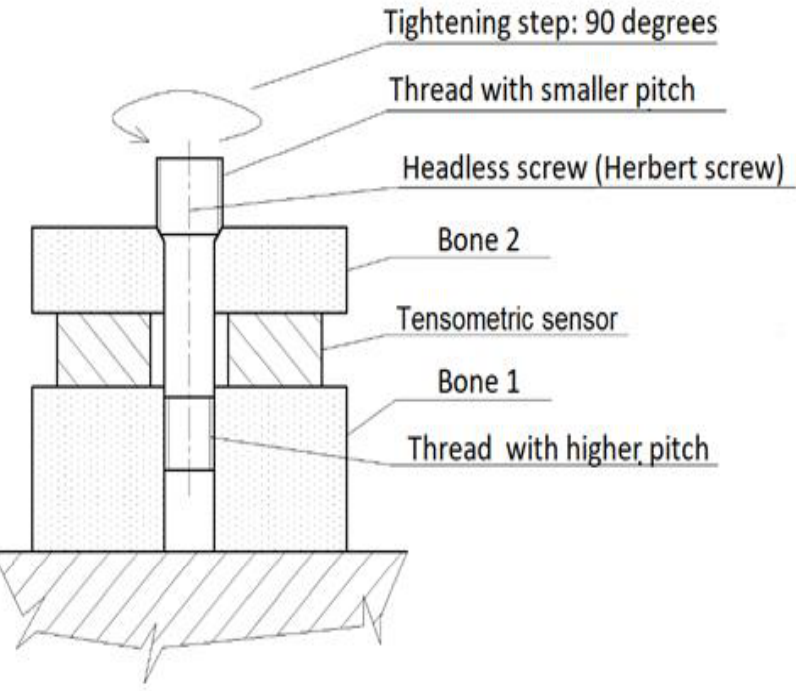
Figure 11. Schema of the experiment.